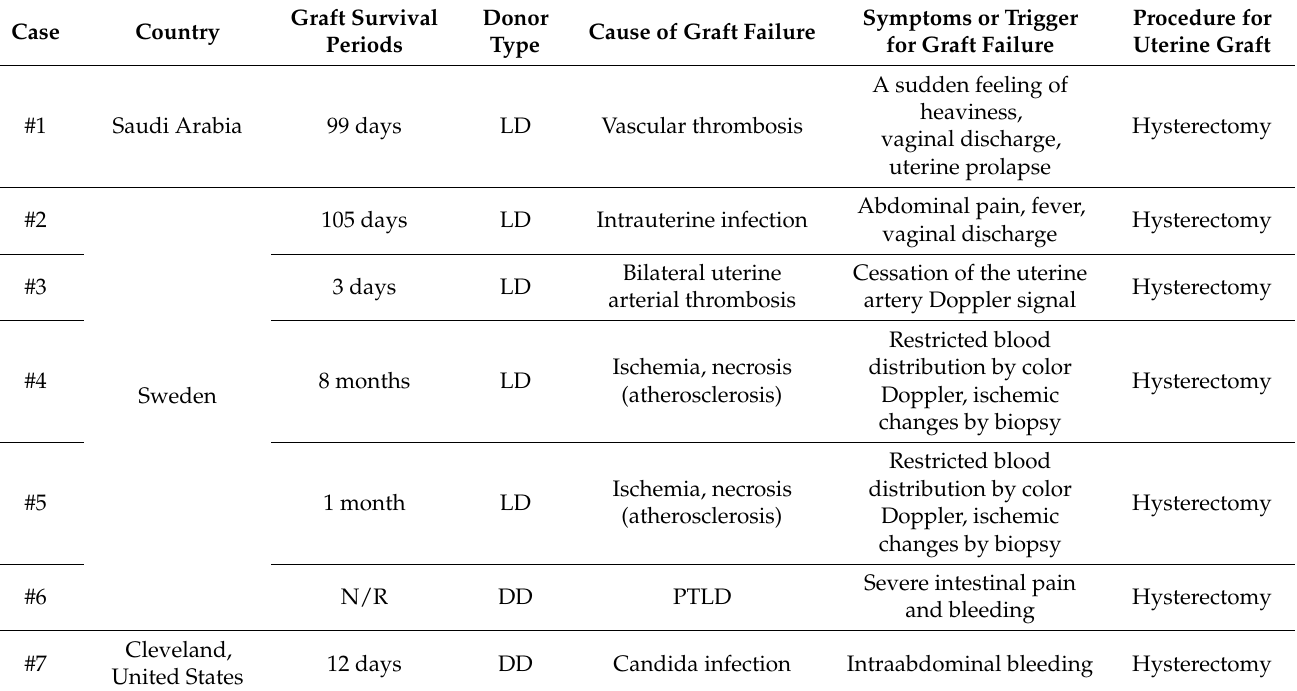
Table 1. Details of graft failure cases after uterus